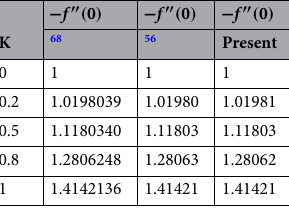
f ′′ ( 0 ) with Khan and Mustafa 68 and Tamoor et al. 56 and when −